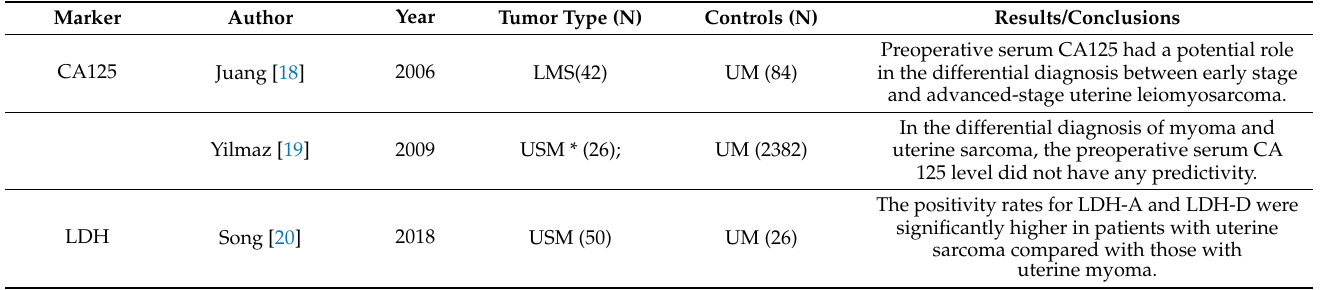
Table 1. Overview of studied protein biomarkers in uterine sarcoma in serum or